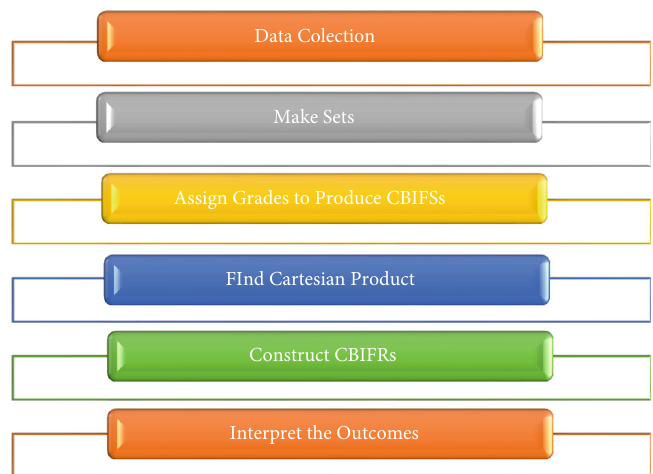
Figure 1: Algorithm of the